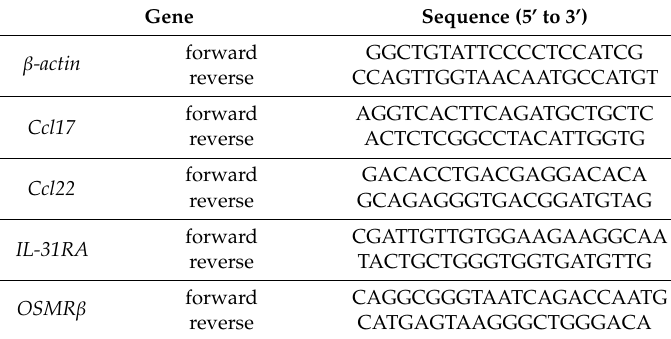
Table 1. The sequences of